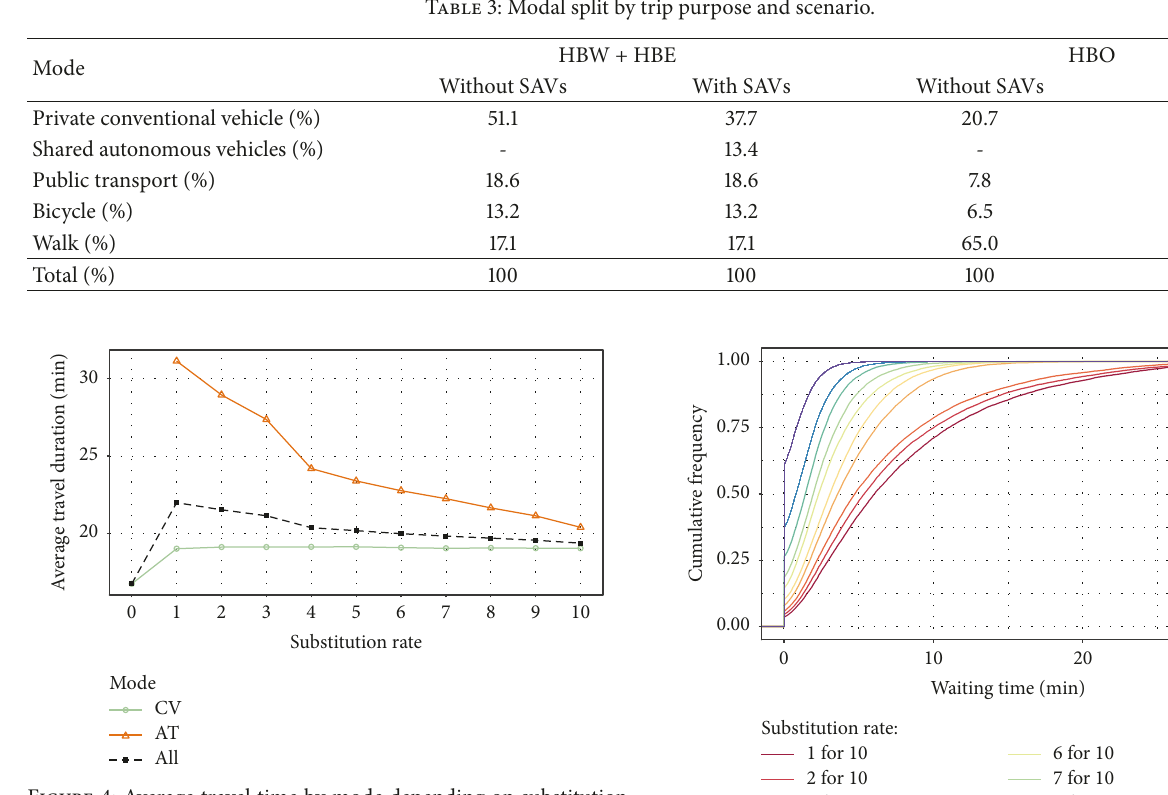
Figure 4: Average travel time by mode depending on substitution rate.